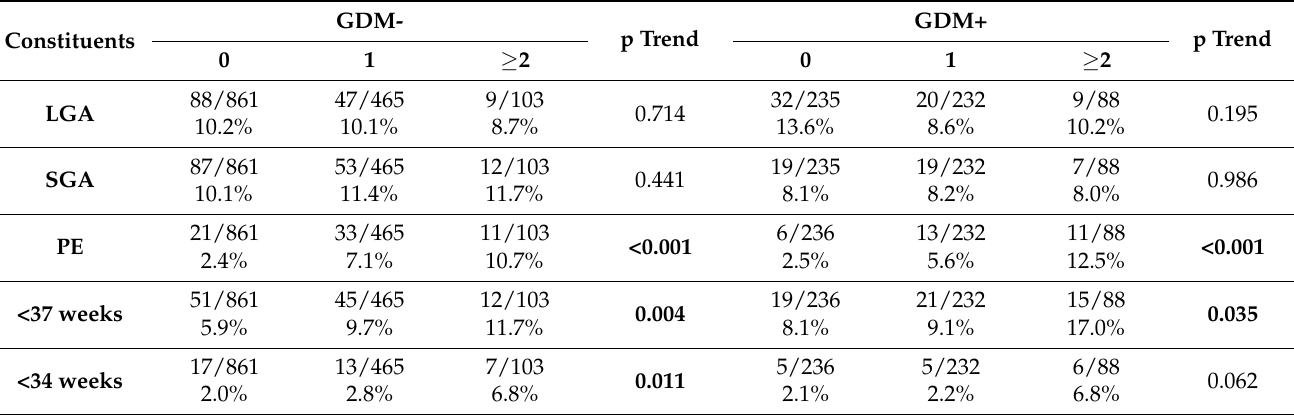
Table 2. Effect of the number of constituents of the metabolic syndrome in absence or presence of GDM on large or small for gestational age infancy, preeclampsia and preterm birth.